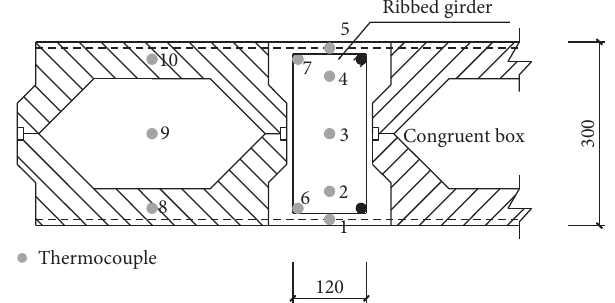
Figure 8: Arrangement of thermocouples.